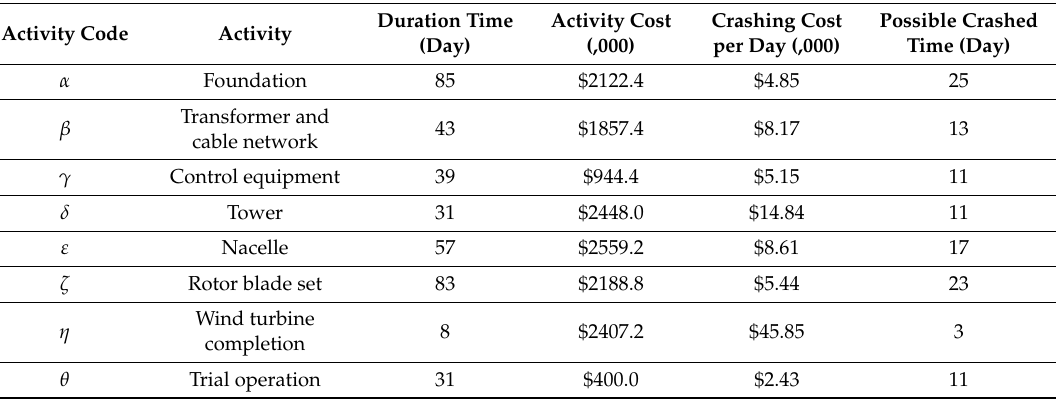
Table 3. Basic construction data for a wind turbine.